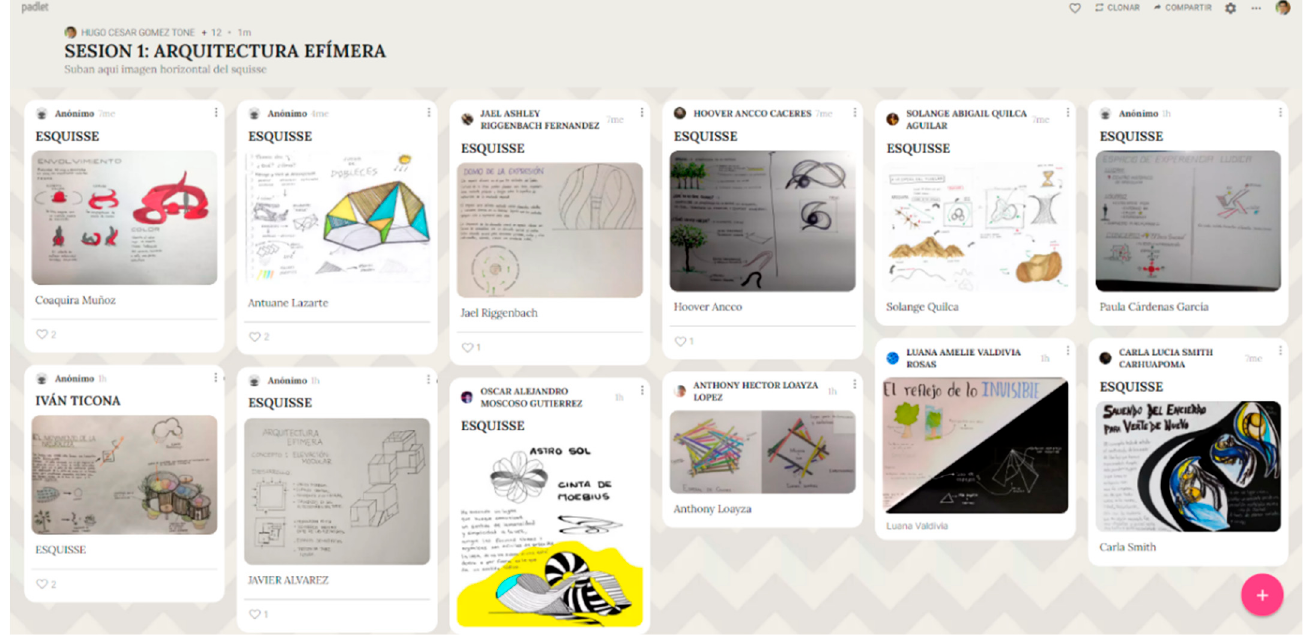
Figure 3. The first phase: a conceptual design by the 12 students, using the traditional method. using IVR.